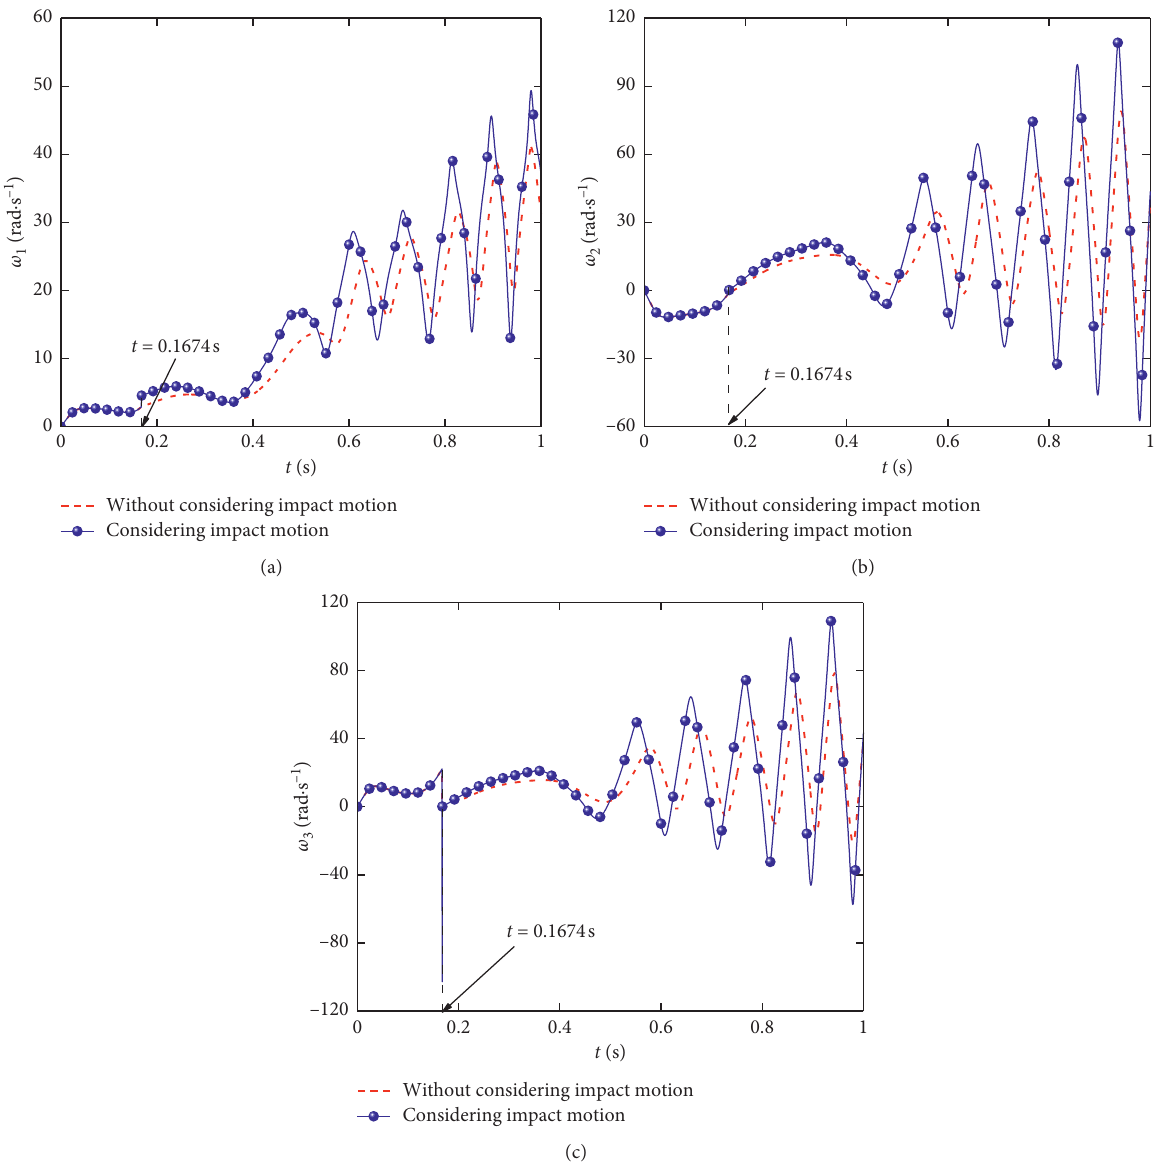
Figure 7: Angular velocity simulations. (a) Angular velocity variation of component 1. (b) Angular velocity variation of component 2. (c) Angular velocity variation of component